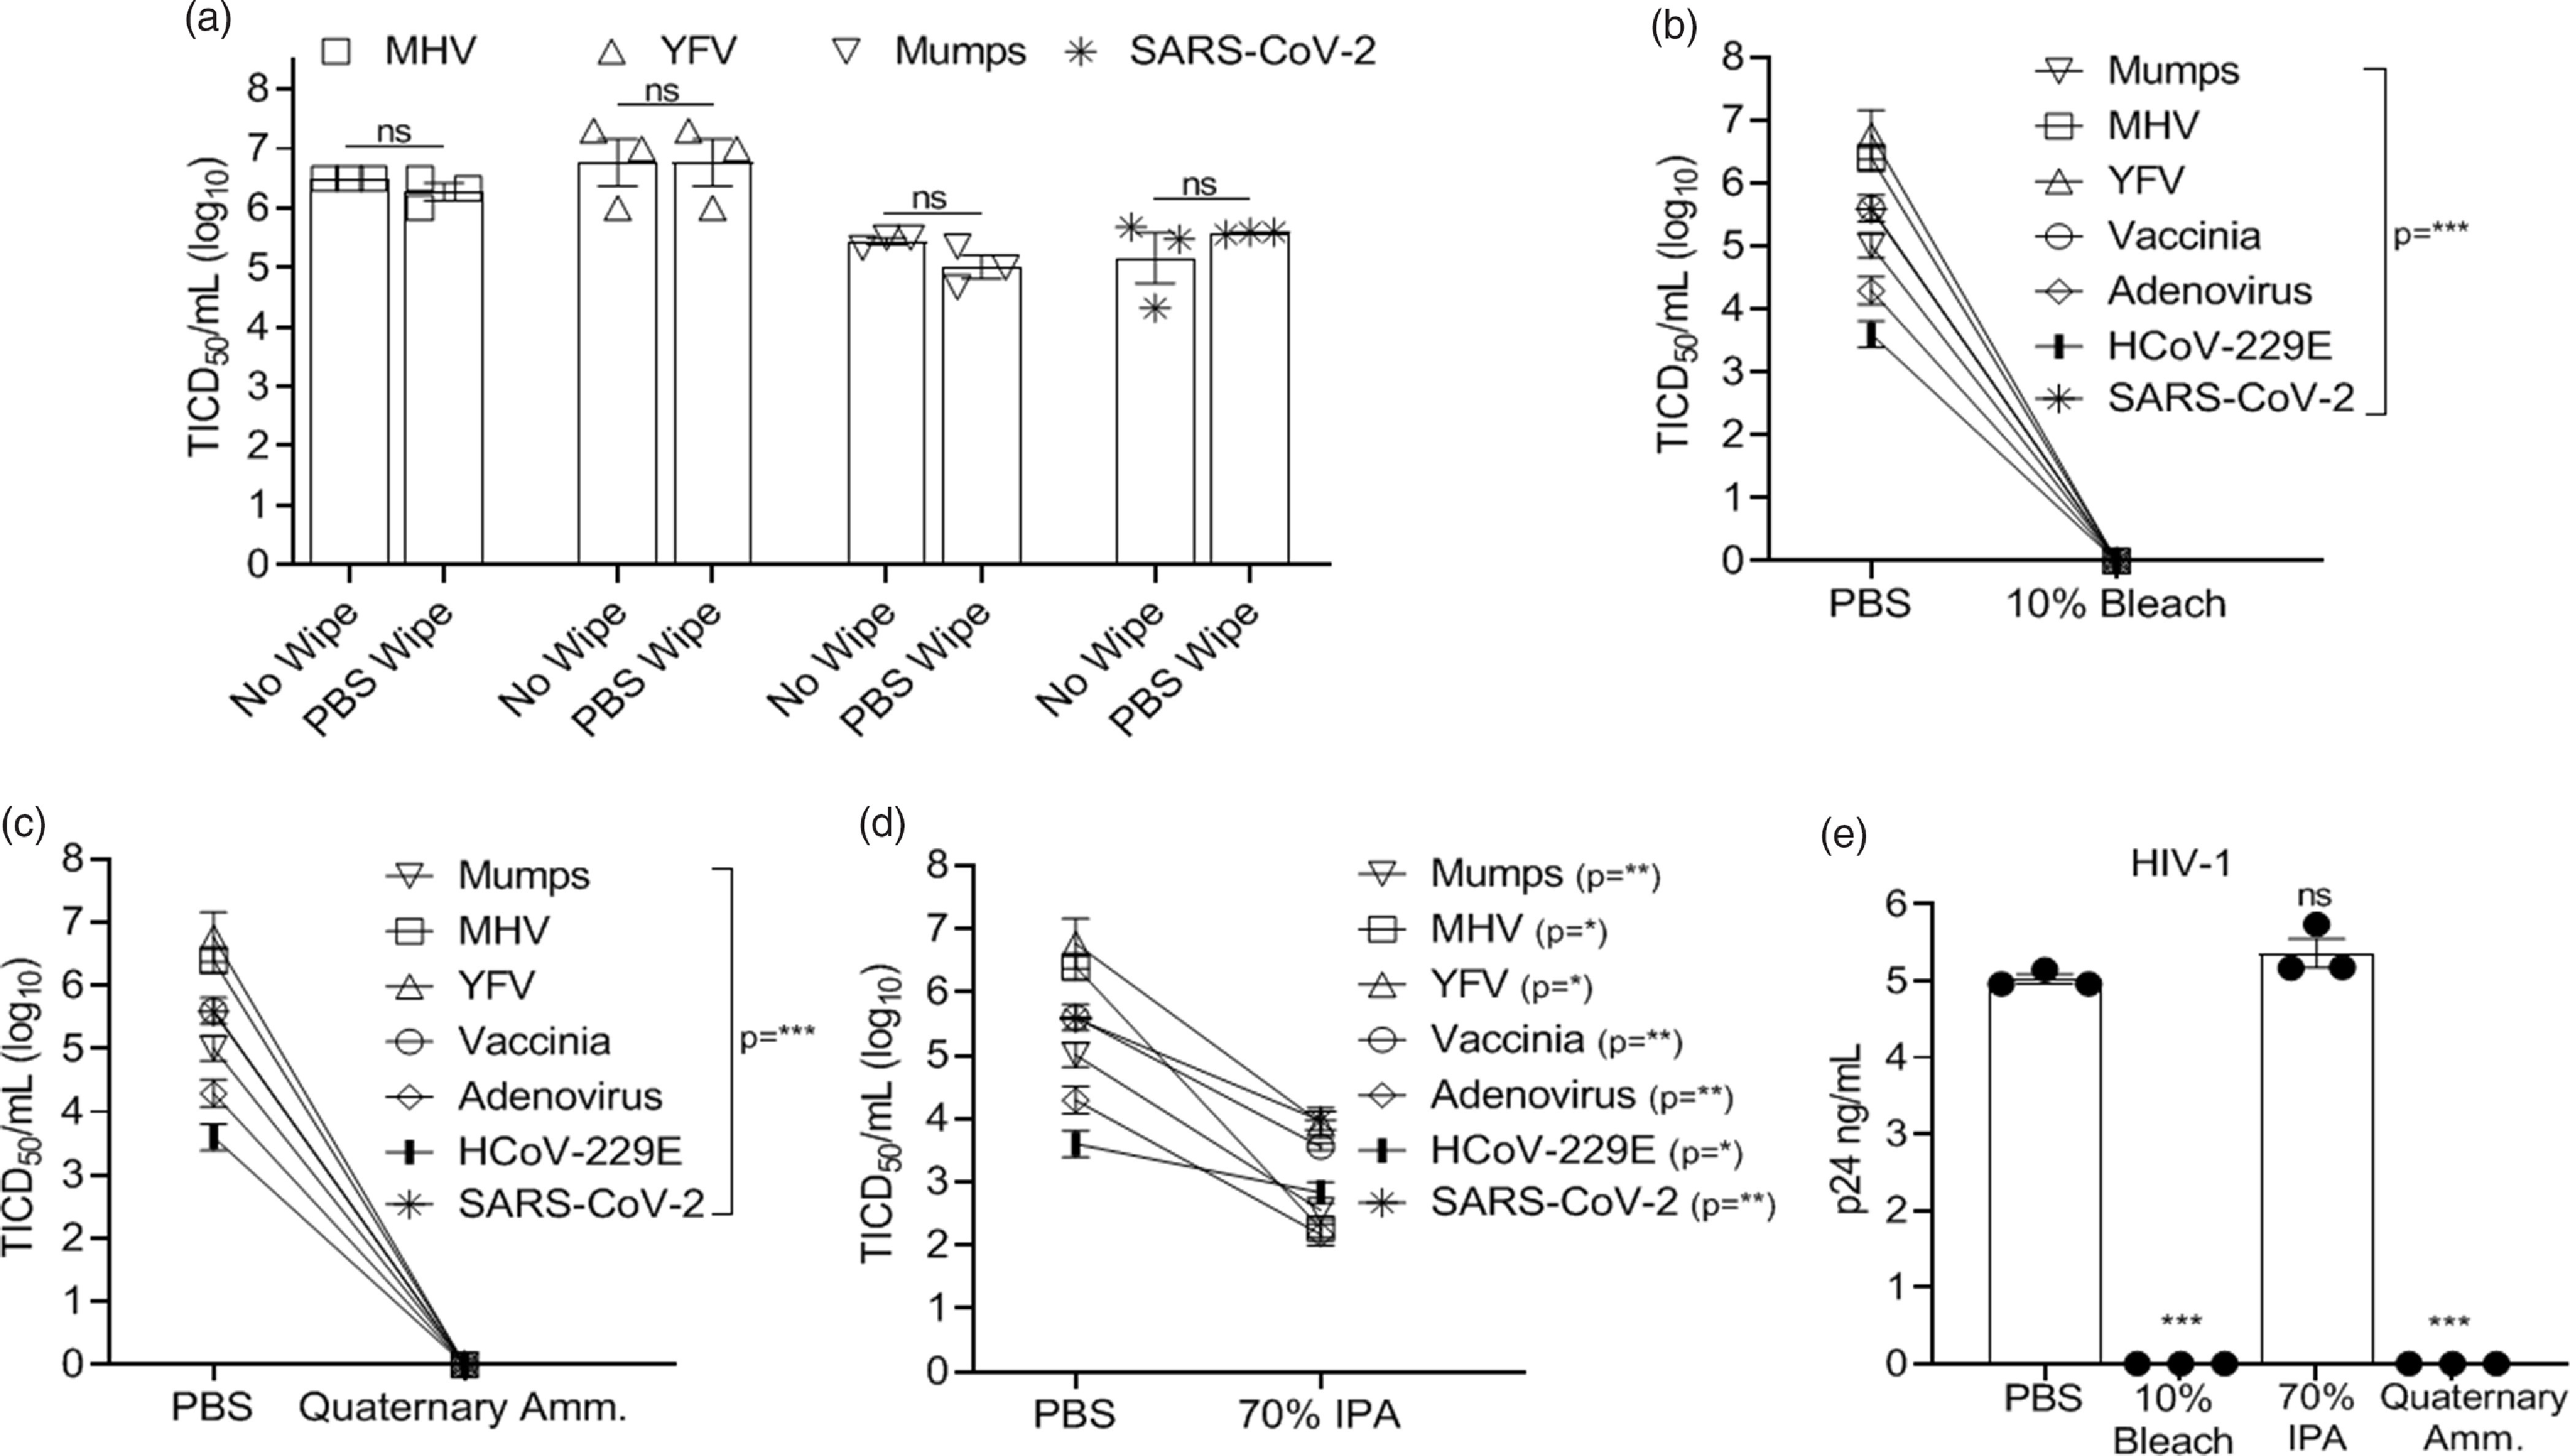
Virus inactivation (log10) on 3D-printed materials by method and type of chemical disinfection. Recovery of virus from 3D-printed mask material after exposure to a single-wipe application of (A) phosphate-buffered saline (PBS), (B) 10% bleach, (C) ammonium quaternary compounds, and (D) 70% IPA. (E) Recovery of HIV-1. Virus titer was completed as described in the methods in the cell typed indicated in Table 1. Significance was determined using the Student t test. *P < .05; **P < .01; ***P < .001; ****P < .0001; ns, not significant. Error bars represent standard error of the mean (SEM) of 3 independent experiments. Note. TCID50, median tissue culture infectious dose, MHV, mouse hepatitis virus, YFV, yellow fever virus, IPA, isopropyl alcohol. HIV-1, human immunodeficiency virus type 1.